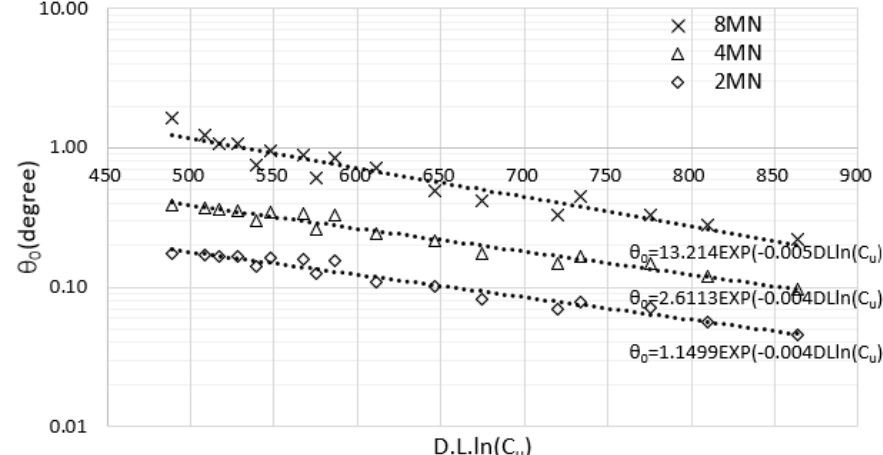
Figure 14. Relationship between D × L × ln ( C u ) and the corresponding pile rotation in the first cycle (agreement from Equation